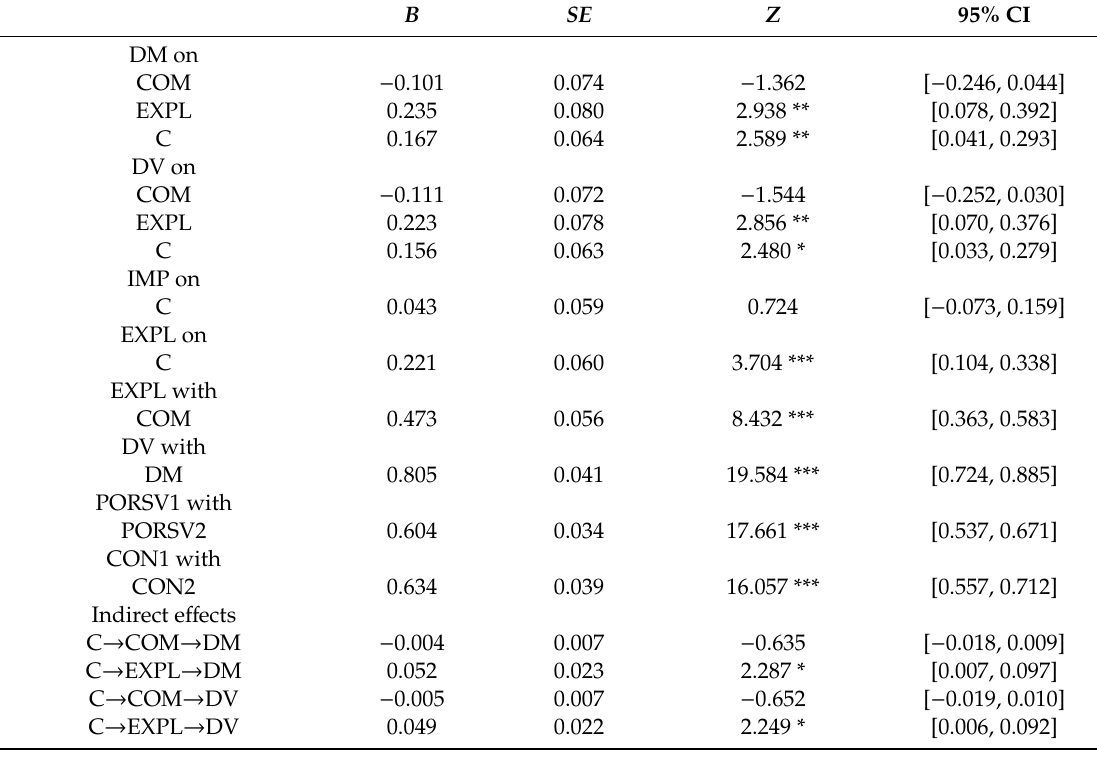
Table 2. Standardized estimates of direct and indirect e ff ects of the tested model (n =